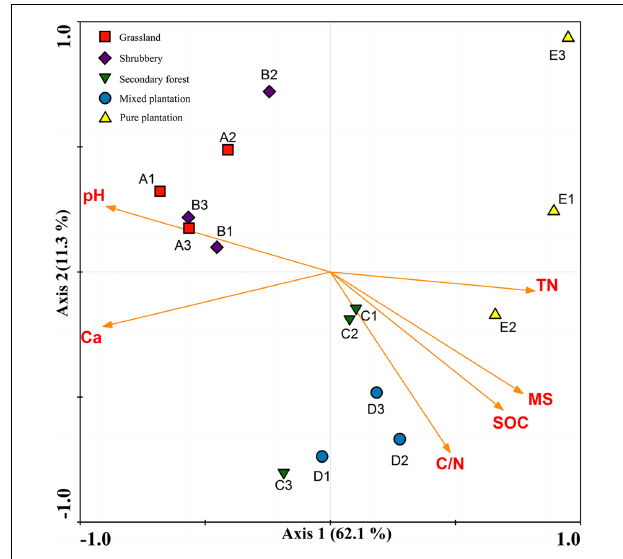
FIGURE 4 | Redundancy analysis to show correlation between the bacterial communities and physicochemical properties under five vegetation types.